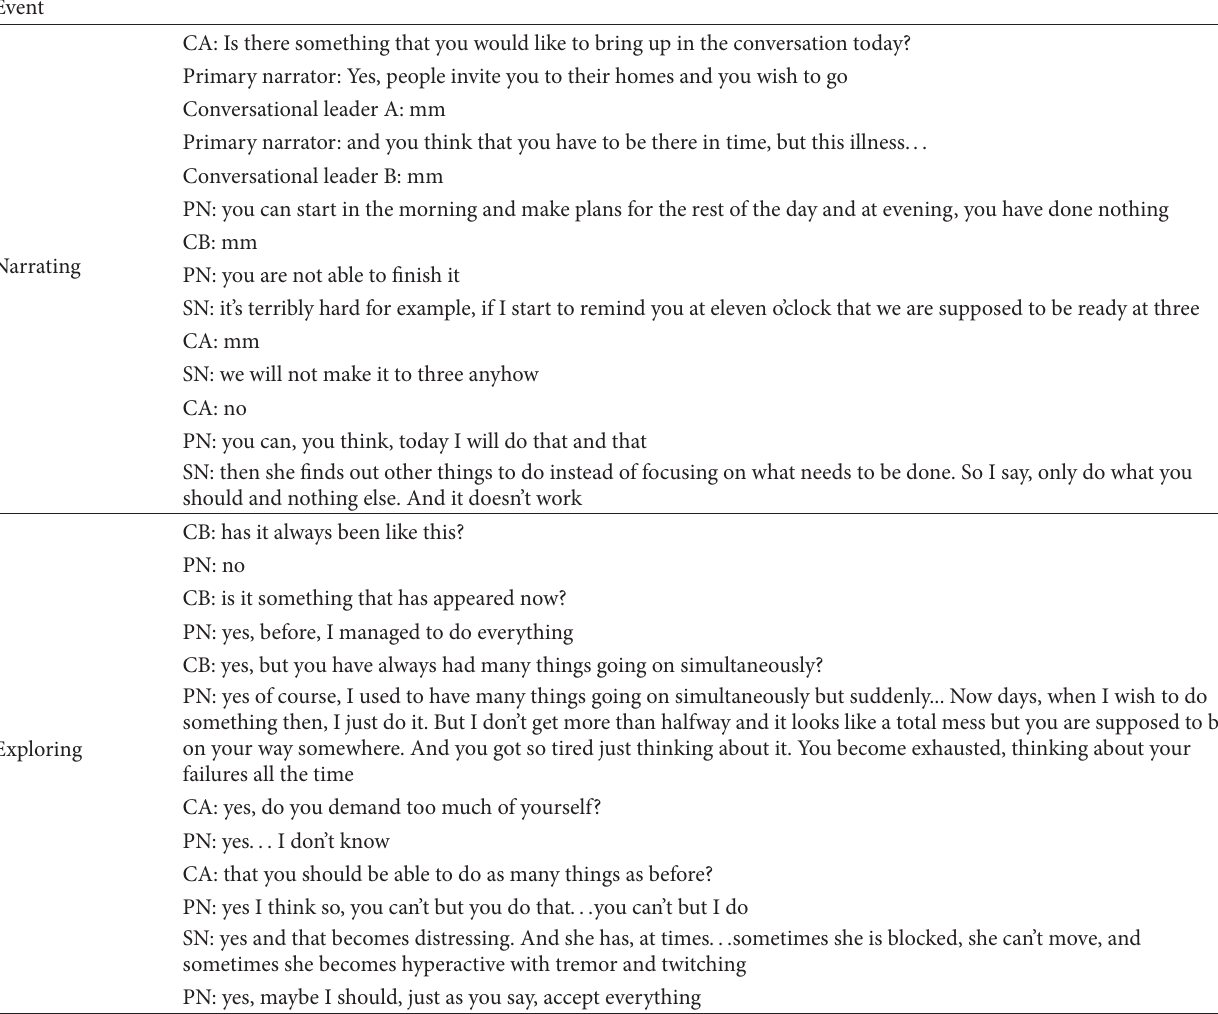
Table 3: Example of one narrating and exploring event in one Family Health